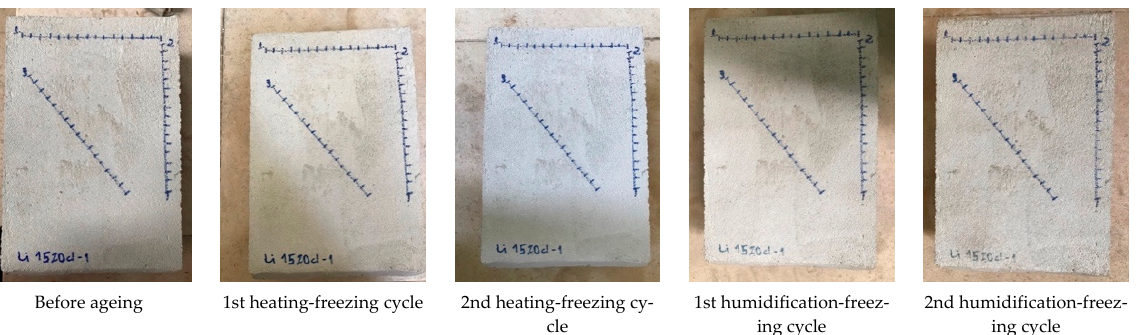
Figure 17. Visual aspect of the flax fibre-reinforced cement-lime mortar during the artificial ageing test.